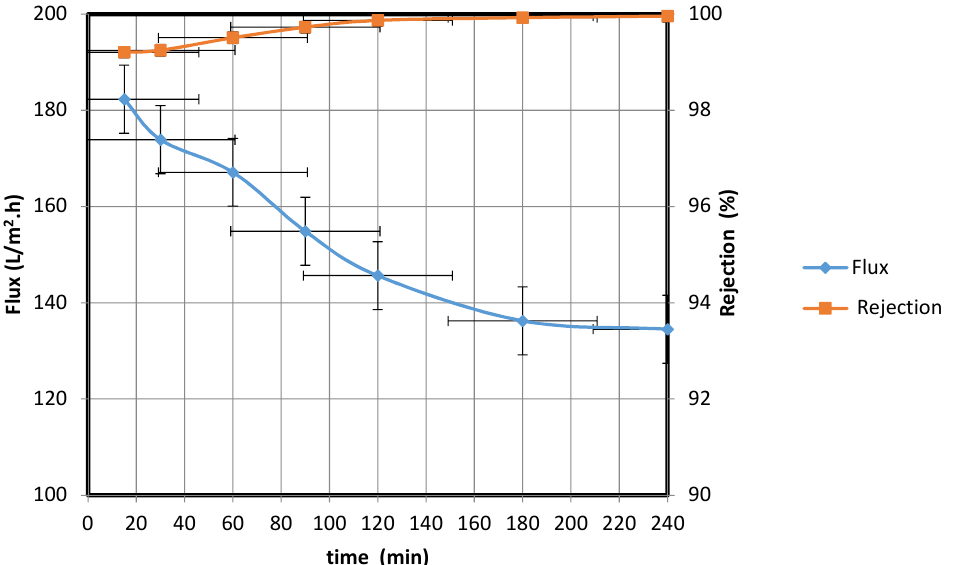
Figure 14. Water / bentonite clay permeate flux rate through fabricated membrane and percentage Figure 14. Water/bentonite clay permeate flux rate through fabricated membrane and percentage rejection of suspended rejection of suspended materials.